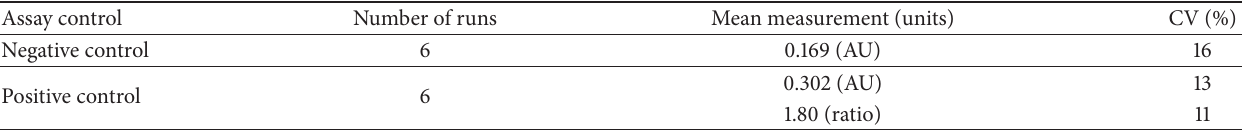
Fusion positive control at 125ng/mL. AU = absorbance units; CV = coefficient of variation. Ratio = positive control signal/negative control signal.